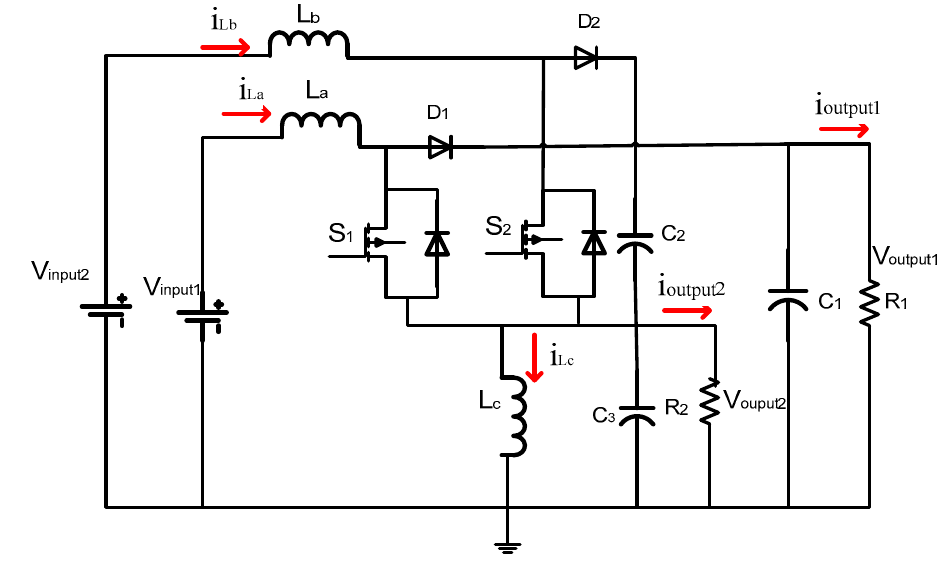
Figure 2. Circuit diagram of proposed converter.